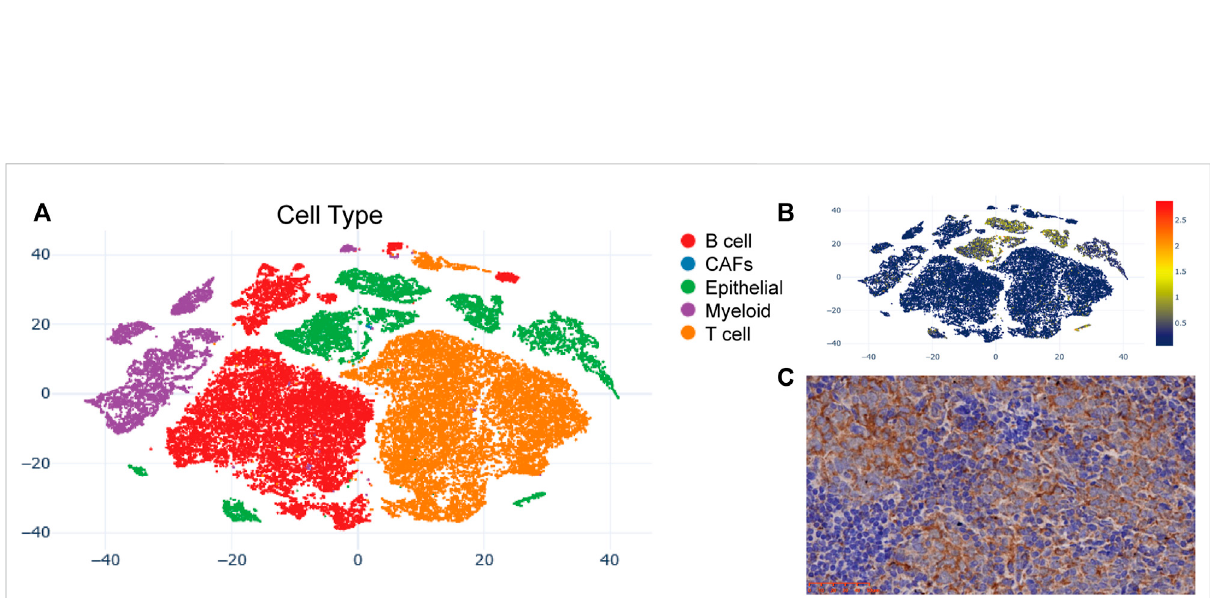
FIGURE 5 PKP1 expression analysis in NPC patients. (A) The t-SNE plots of cells with each cell color-coded to indicate the different cell types; (B) The mRNA expression of PKP1 in cells de fi ned above; (C) Immunohistochemical staining of PKP1 protein was performed in 10 NPC tissues. A representative image is shown. Scale bars are shown in